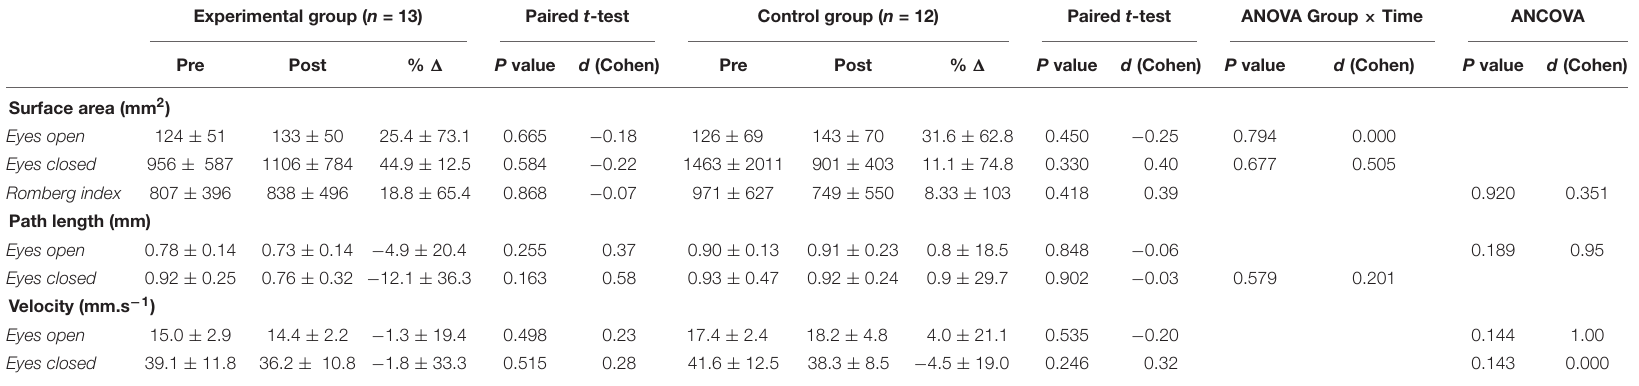
TABLE 4 | Dynamic balance in antero-posterior plane before and after